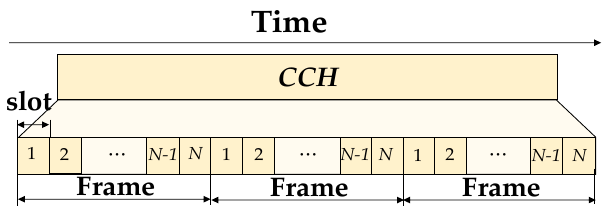
Figure 2. Time division multiple access (TDMA) frame structure of the proposed protocol.